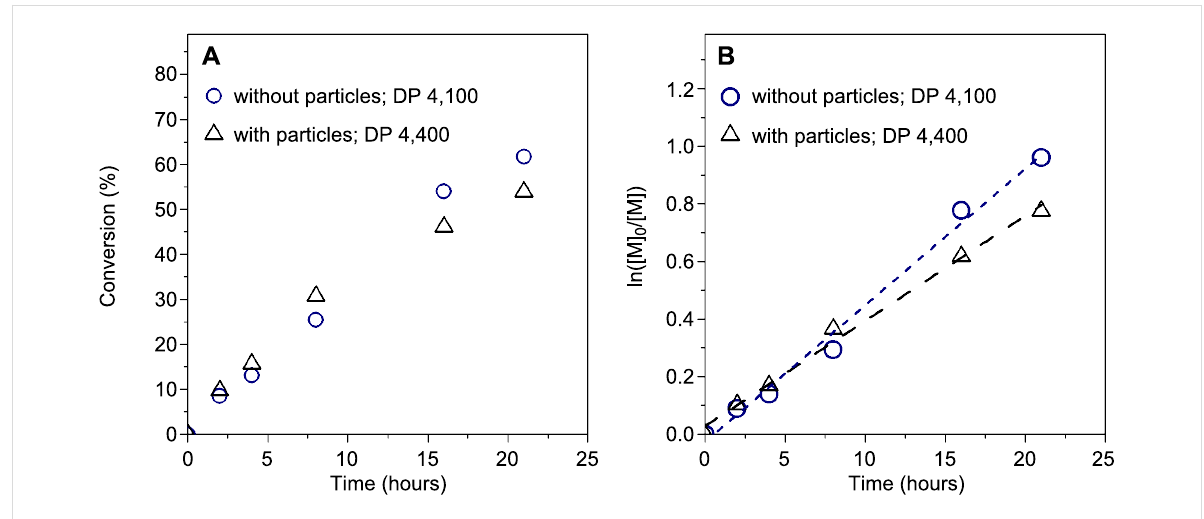
Figure 3: AIBN-initiated, PABTC-mediated polymerization of VBC with (triangles, DP 4,400) and without (circles, DP 4,100) SiP–RAFT particles: (A) monomer conversion versus reaction time; (B) pseudo-first order plots with dashed lines indicating linear fits of the data (long dashes, with particles, DP 4,400; short dashes, without particles, DP